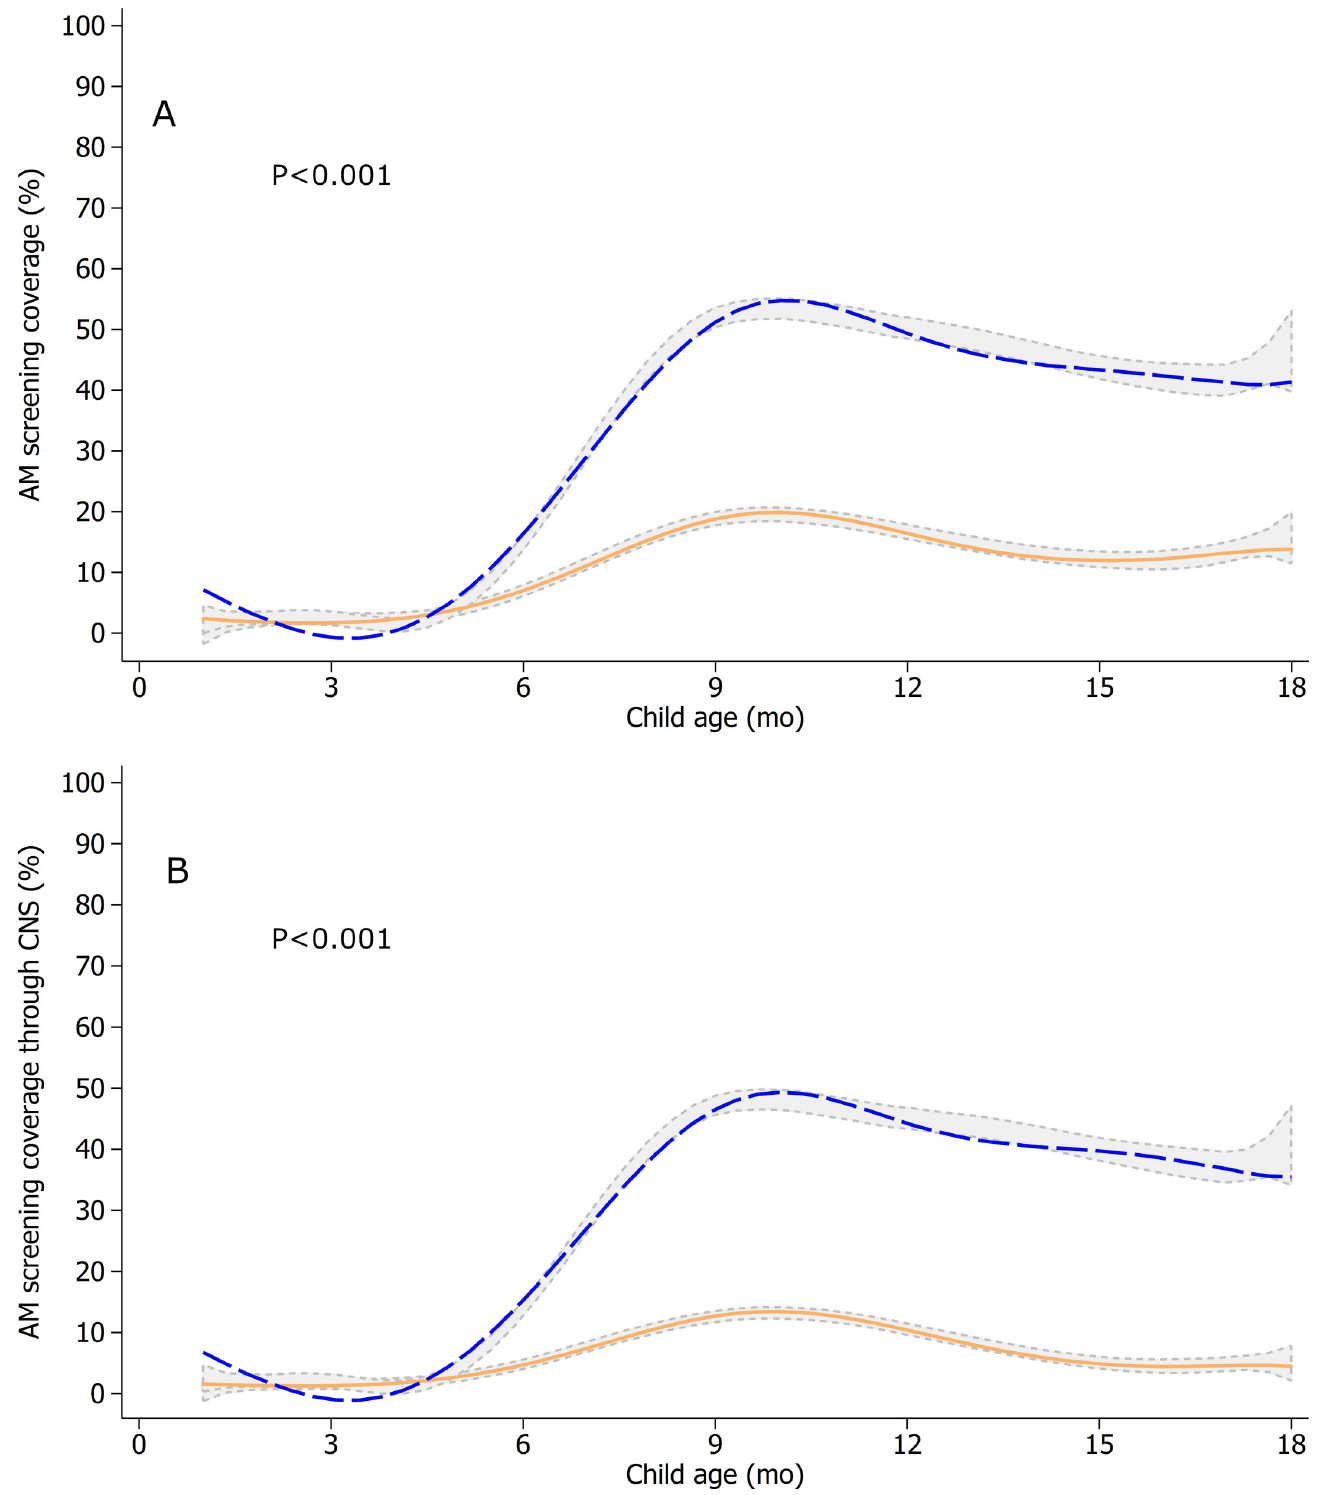
Fig 3. AM screening coverage by any actor (A) and through CNS (B) in the longitudinal study by age and by study group. Monthly screening was defined as MUAC measured ( � 6 months old) and/or weight and length measured (all ages) in the past month, as per caregiver recall. The orange solid line represents fitted values for the comparison group. The blue dashed line represents fitted values for the intervention group. Gray areas represent 95% confidence bands of kernel-weighted local